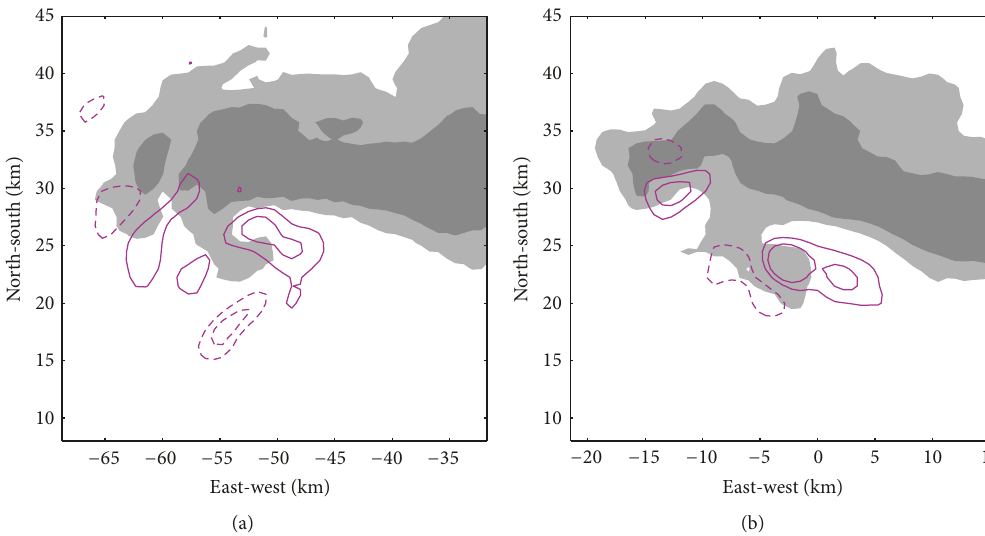
Figure 15: Horizontal cross-section at 250 m altitude of reflectivity at 30 (contoured in grey) and 50 dBZ (contoured in dark grey) with 0–5 km average vertical vorticity contoured in magenta every 5 × 10 −3 s −1 at (a) 2358 UTC 29 May 2004 and (b) 0112 UTC on 30 May 2004. Solid (dashed) contours denote positive (negative) values of average vertical vorticity.